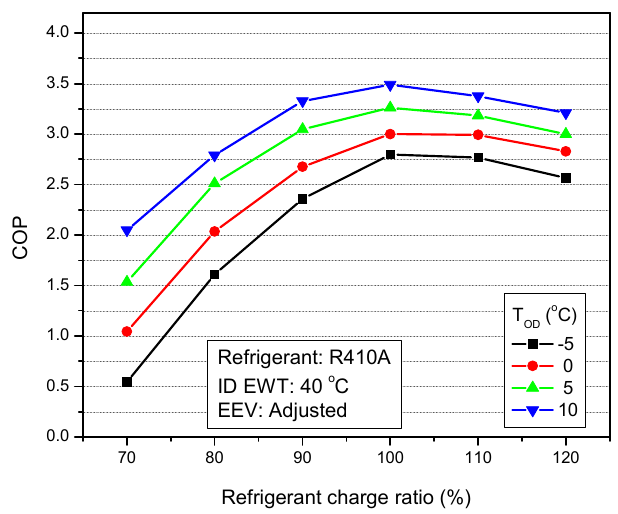
Figure 16. Variation of COP with refrigerant charge ratio and T OD .